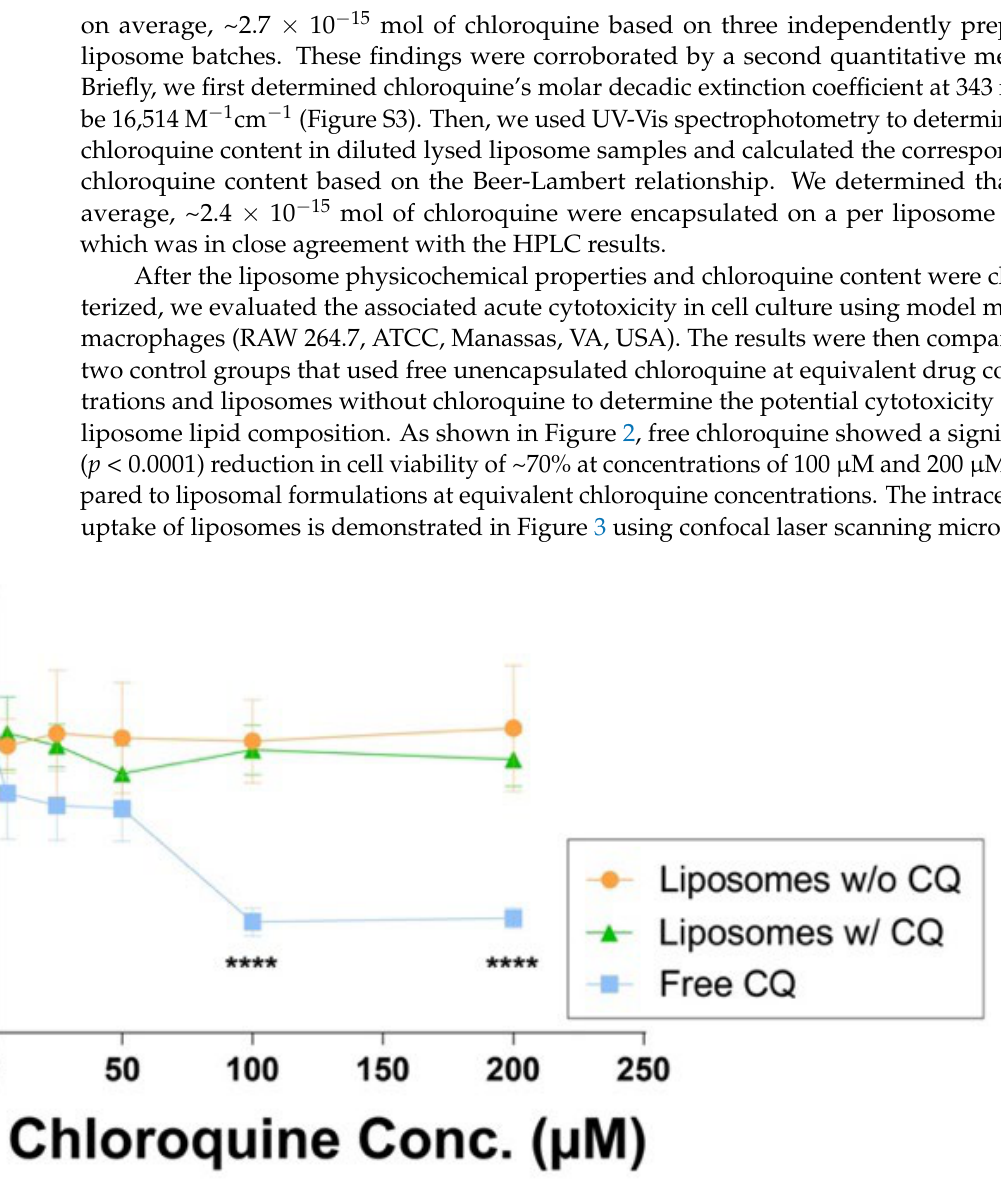
Figure 2. Cell viability of RAW 264.7 macrophages exposed to liposomes w/o chloroquine (CQ), liposomes w/chloroquine, and free chloroquine ( n = 5) for 8 h. Data points represent mean +/ − SD. Statistical differences were determined using a two-way ANOVA and Tukey’s multiple comparisons (**** p < 0.0001).